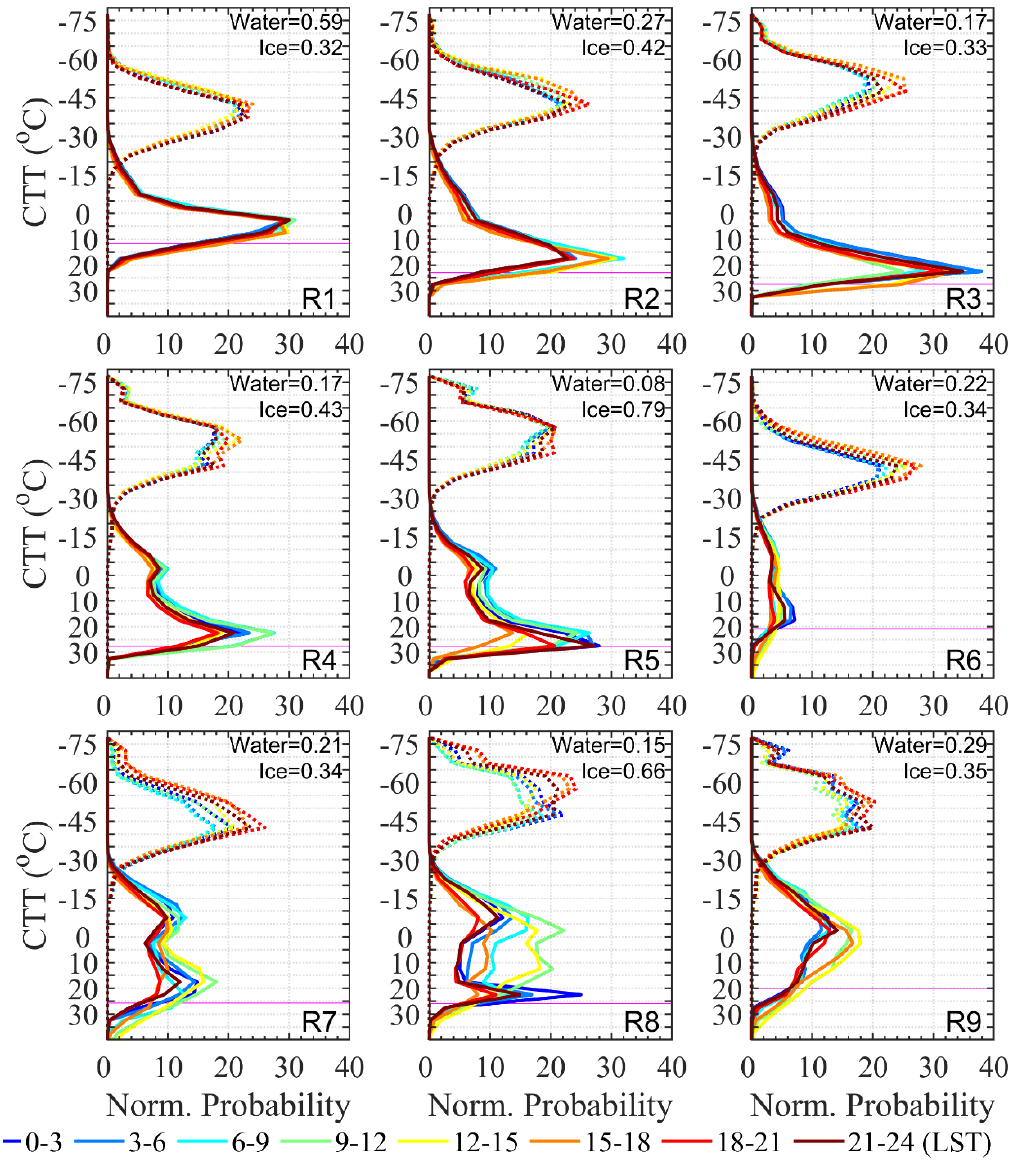
Figure 13. Normalized probability (unit: %) distributions of water (solid lines) and ice (dotted lines) phases for every 3 h over the nine regions of interest during the 3-year boreal summer with respect to the cloud-top temperature (CTT) calculated at 5 ◦ C intervals. The normalized probability for a certain phase is defined as the actual probability divided by the seasonal mean frequency, indicated in the upper-right corner of each panel. Magenta horizontal lines indicate seasonal mean near-surface air temperatures.